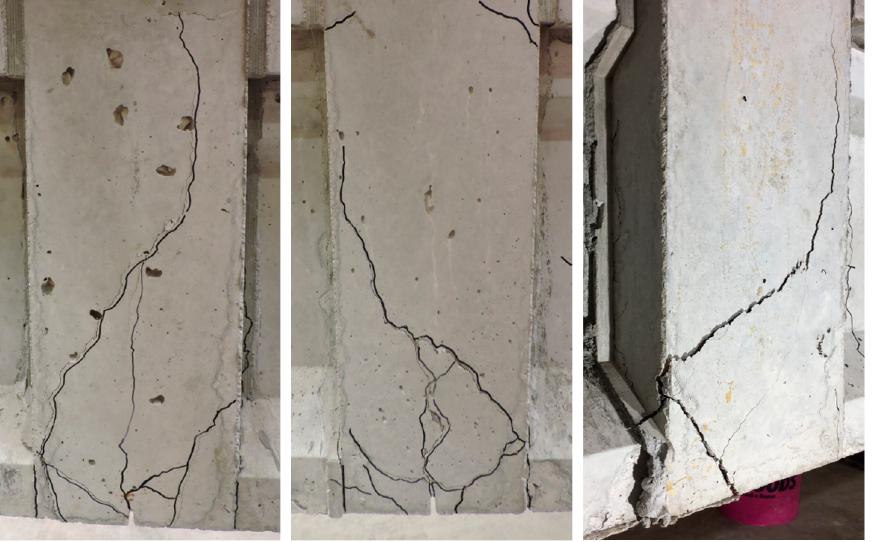
Figure 6. Example crack patterns in the connected girder specimens when subjected to positive moment bending.